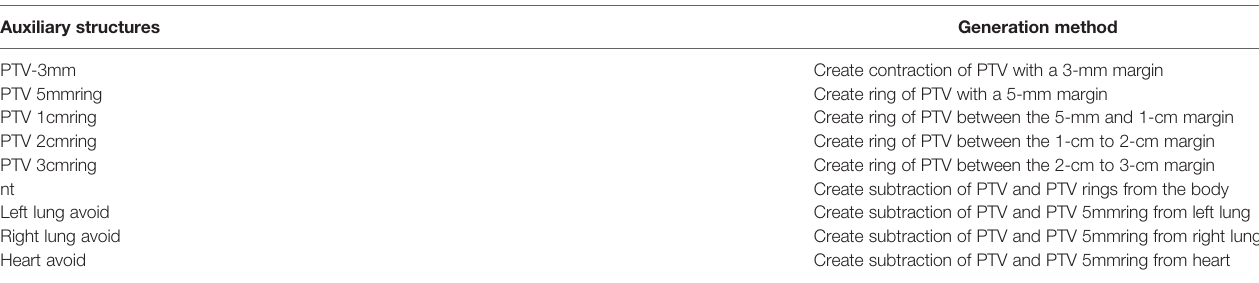
TABLE 3 | Generation method of auxiliary structures.